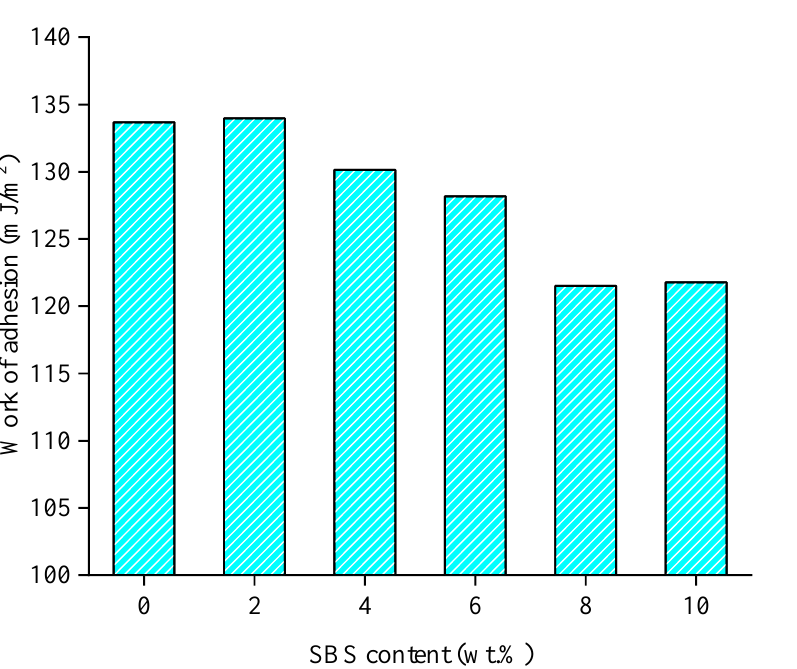
Figure 7. Variation in work of adhesion between SBS modified asphalt binder and quartz with SBS content. SBS